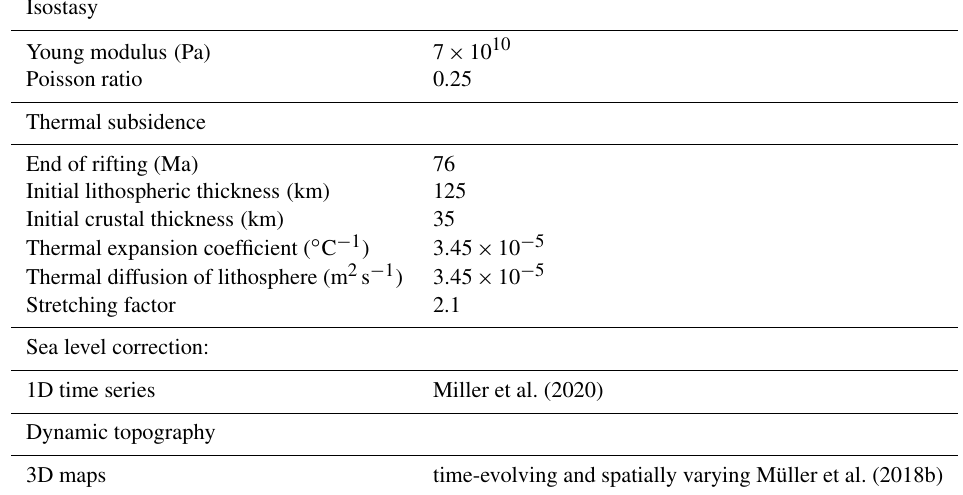
Table A1. Physical parameters values used in the case